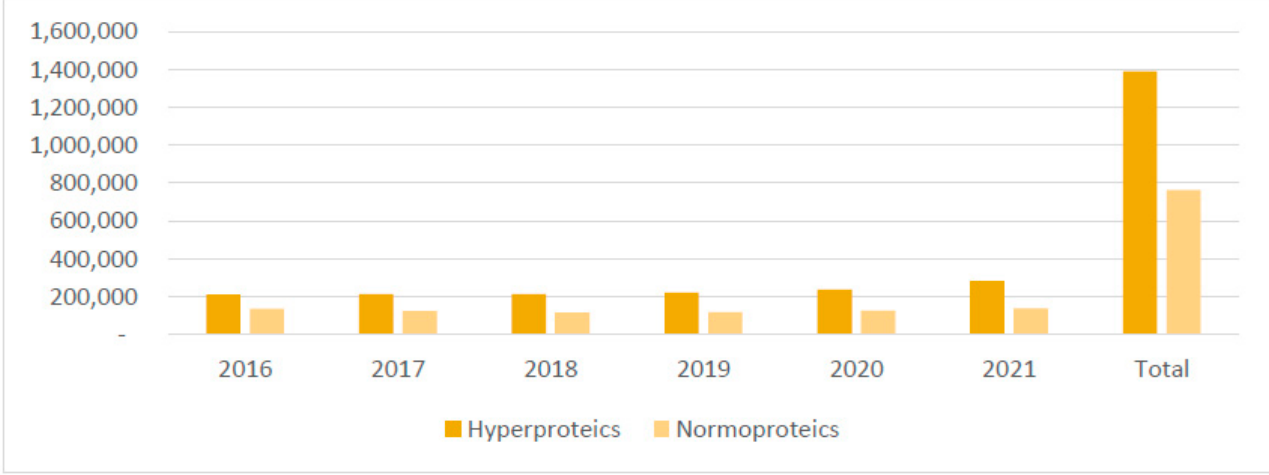
Figure 3. Number of total packs consumed of hyperproteic vs. normal protein (normoproteic) diet therapeutic products from 2016 to 2021 in the Community of Madrid.